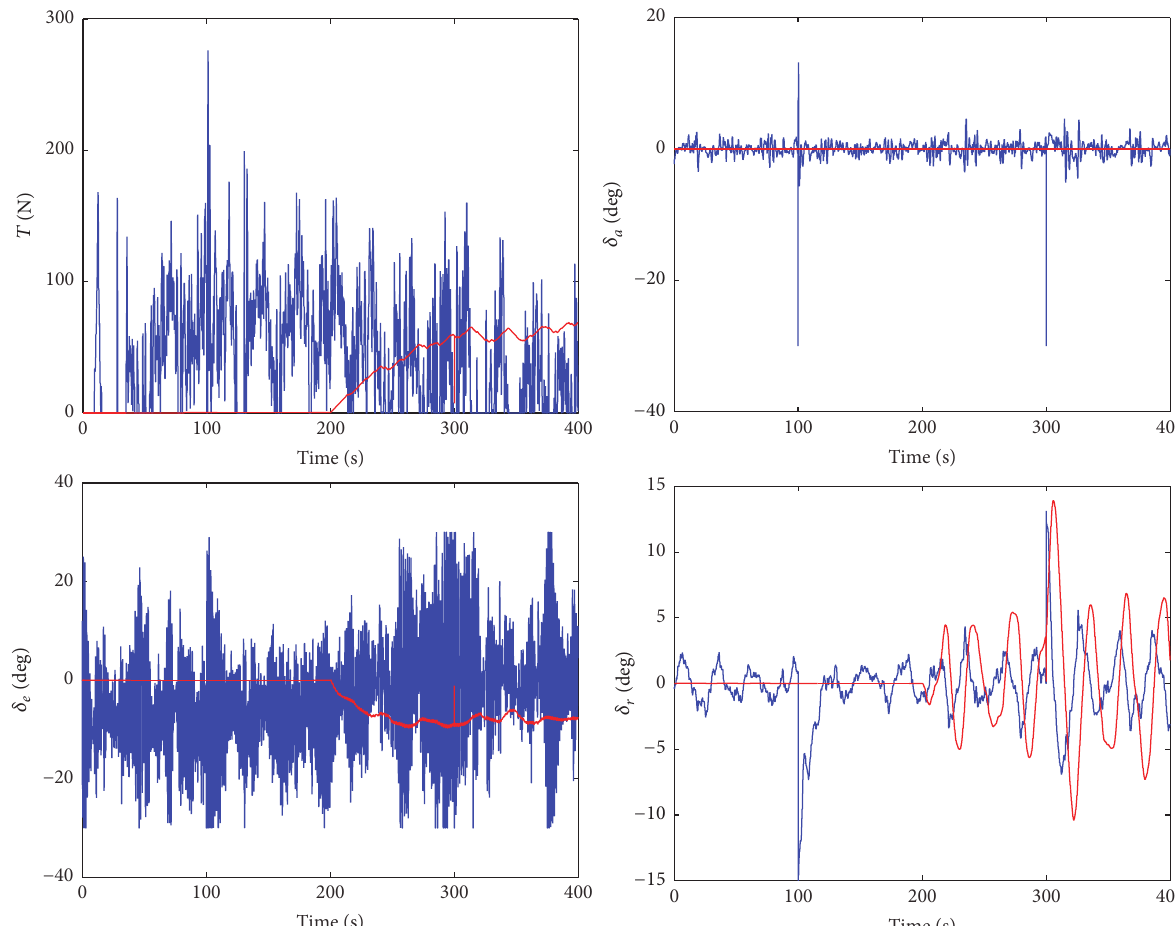
Figure 6: Time responses of the thrust ( 𝑇 ), aileron ( 𝛿 𝑎 ), elevator ( 𝛿 𝑒 ), and rudder ( 𝛿 𝑟 ) deflections for the P controller (blue line) and the FNN (red line).